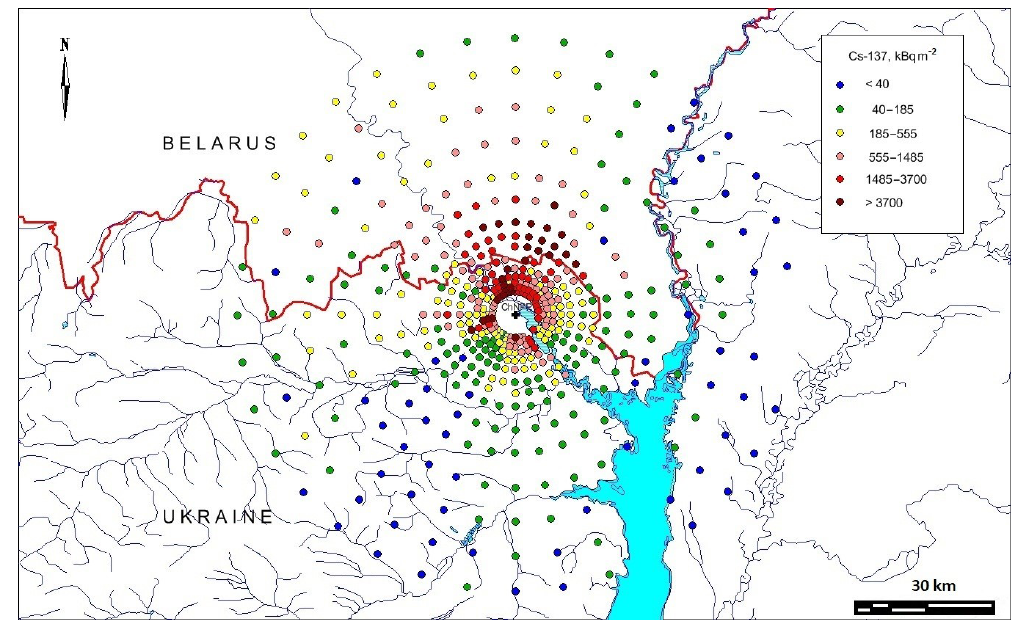
Figure 4. The fallout density of 137 Cs (kBqm − 2 ) within the 60km zone around the ChNPP decay corrected to 6 May 1986.